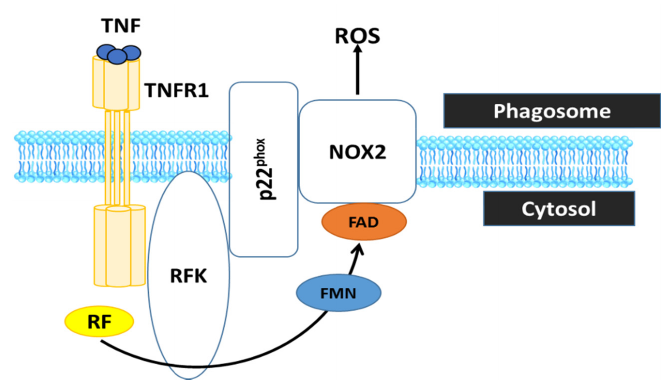
Figure 4. RF is converted by RFK into FMN and FAD, which is essential cofactor the phagocytic